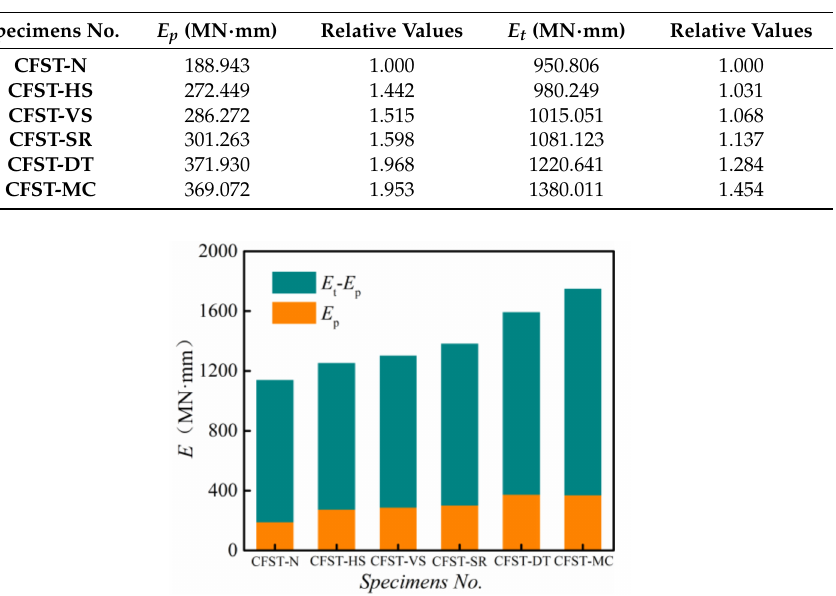
Table 6. Cumulative energy dissipation.